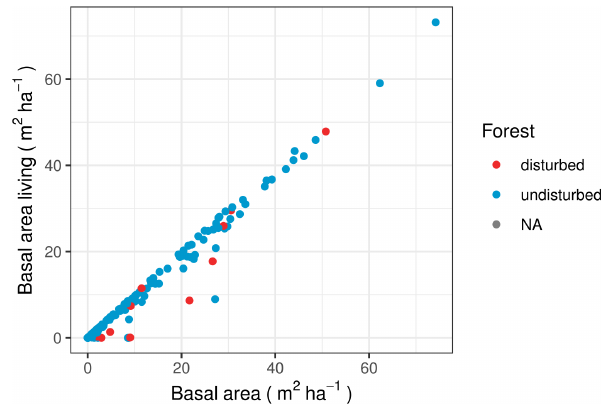
Figure 10. Living wood volume compared to overall wood volume. Plots with recent forest loss are marked